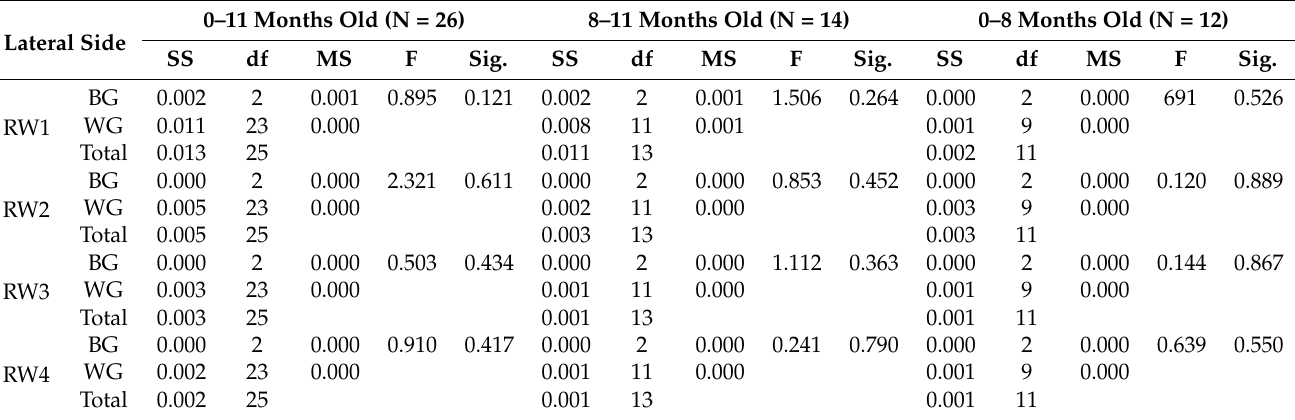
Table 2. ANOVA One-way results from lateral side data.